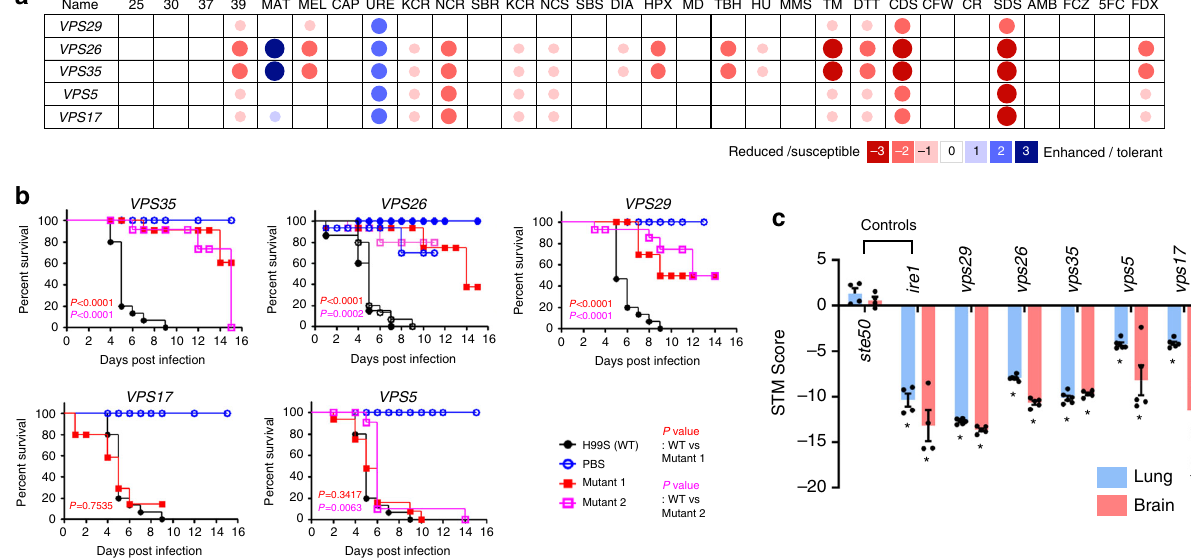
Fig. 5 The role of retromer complex in the pathogenicity of C. neoformans . a Phenotypic heatmap of retromer complex mutants constructed based on in vitro phenotypic traits [ vps29 Δ (YSB4881, YSB4882), vps26 Δ (YSB5671, YSB5672), vps35 Δ (YSB5615, YSB5616), vps5 Δ (YSB5683, YSB5684), and vps17 Δ (YSB5724)] (Supplementary Fig. 12). b , c The retromer complex is involved in the pathogenicity of C. neoformans . b Insect-killing assay performed for the retromer complex mutants ( n ≥ 15). P values shown in the graph were calculated using the log-rank (Mantel – Cox) test to measure statistical differences between the wild-type (WT) strain (H99S) and each phosphatase mutant strain. In the VPS26 graph, fi lled and empty circles indicate two independent PBS and WT-infection controls. c Signature-tagged mutagenesis (STM)-based murine infectivity assay ( n = 3). STM scores were calculated by quantitative PCR. The ste50 Δ and ire Δ mutants were used as virulent-positive control and avirulent-negative control strains, respectively. The statistically signi fi cant was calculated by one-way ANOVA analysis with Bonferroni ’ s multiple comparison test. Data are presented as mean values± SEM (* P <